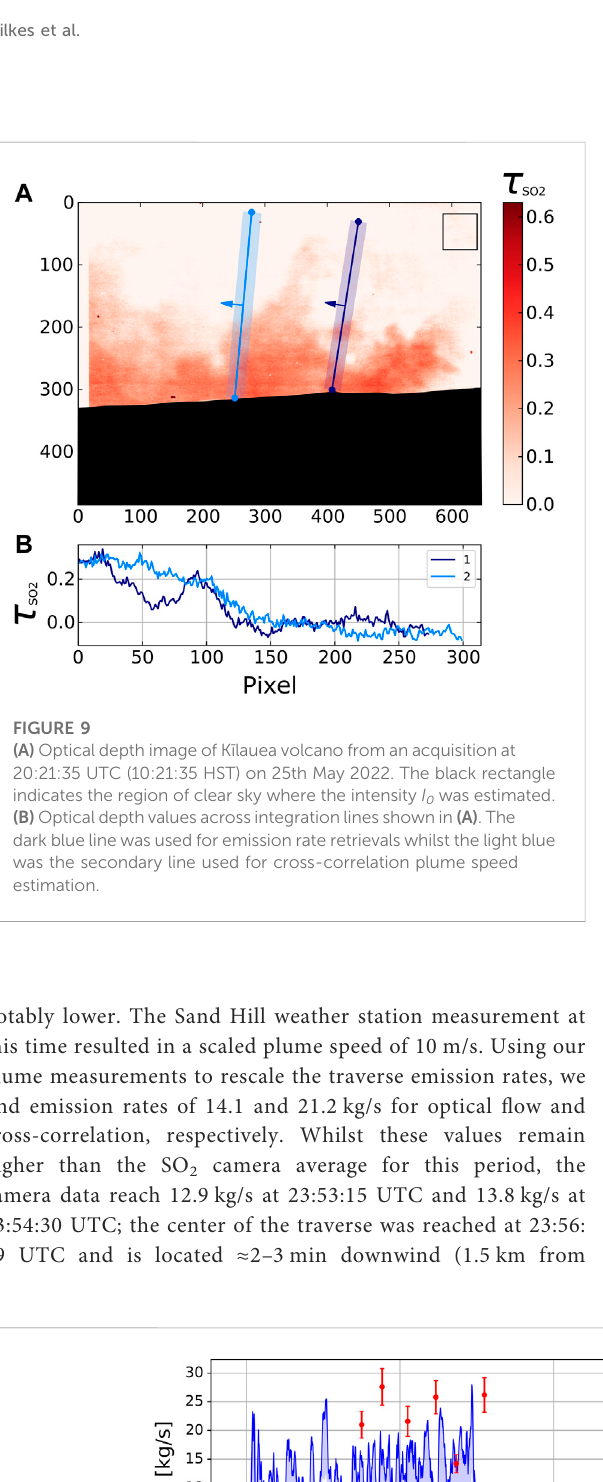
FIGURE 10 Permanent camera SO 2 emission rate ( Φ ) time series at K ī lauea on 25th and 26th July 2022 (UTC; all measurements were 25th July HST), with contemporaneousDOAStraversemeasurements(reddots).Cameraretrievalsweremadewiththecross-correlation( fl ow_glob )plumespeedestimation algorithm. The magnitude of the light dilution correction (applied through the instrument ’ s spectrometer iFit retrievals) is displayed by the shaded blue region. Agreement between the camera and traverse measurements is reasonably good for the 25th measurements, whilst on the 26th the SO 2 camera retrieves signi fi cantly lower emissions rates, albeit with only one traverse measurement for comparison in this sequence. Note that the traverse measurements were performed ≈ 1.5 km downwind of the source, therefore with a plume speed of ≈ 8 – 10 m/s we may expect a lag in measurements of ≈ 150 – 190